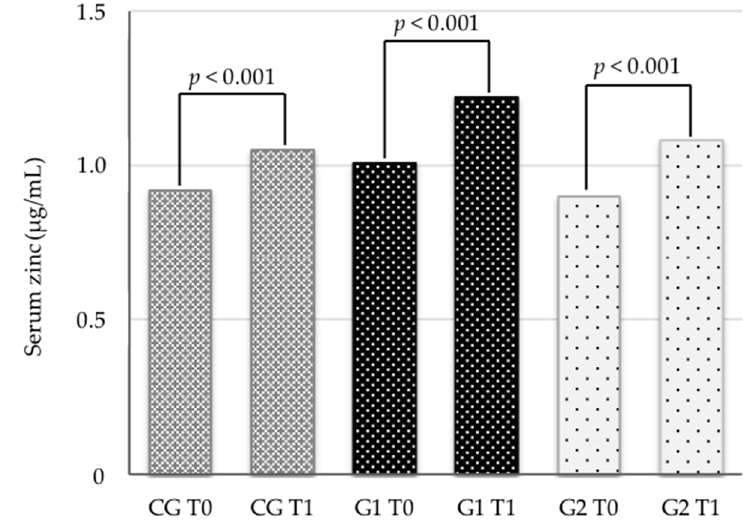
Figure 2. Intragroup comparison of serum zinc before (T0) and after (T1) three months of intervention with di ff erent oral supplementation of zinc in eutrophic children.